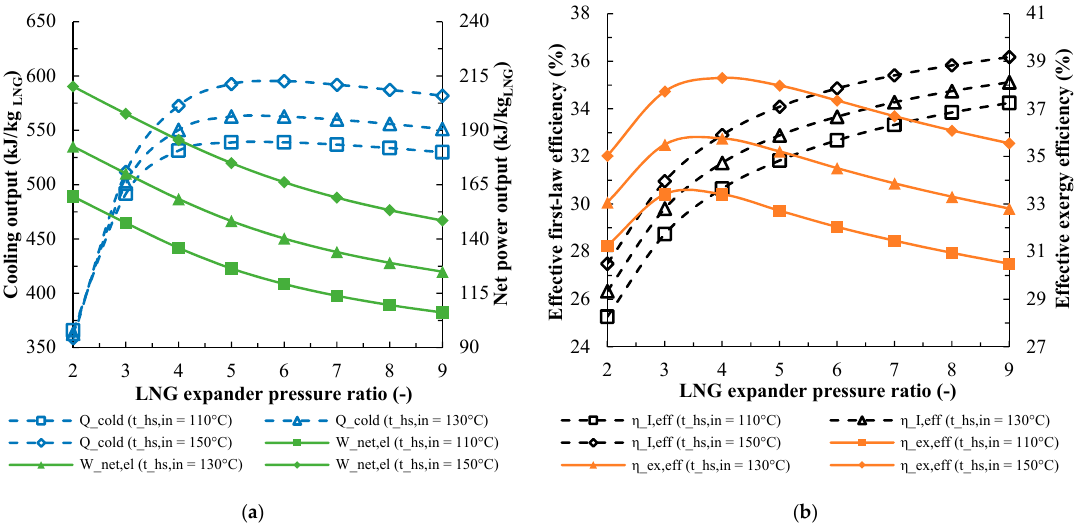
Figure 6. E ff ect of LNG expander pressure ratio on poly-generation system performance at di ff erent Figure 6. Effect of LNG expander pressure ratio on poly-generation system performance at different heat source temperatures ( t 18 = 110 ◦ C, 130 ◦ C, and 150 ◦ C): ( a ) Useful cooling and electrical power heat source temperatures ( (cid:1872) (cid:2869)(cid:2876) = 110 °C, 130 °C, and 150 °C): ( a ) Useful cooling and electrical power outputs; ( b ) Overall e ffi outputs; ( b ) Overall efficiencies.